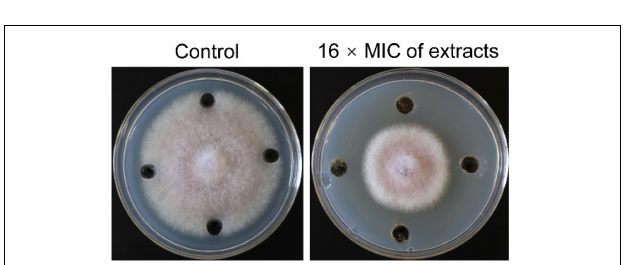
FIGURE 6 | Inhibition assay of strain SCA2-4 T extracts on the mycelial growth of Foc TR4. 10% of DMSO treatment was used as control.